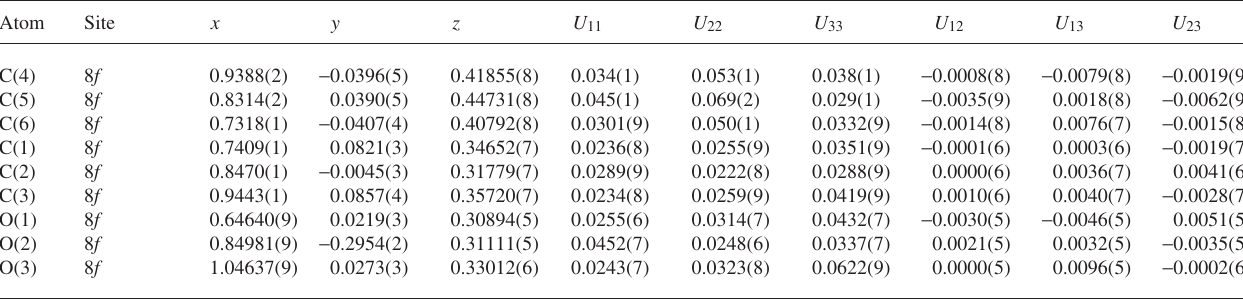
Table 3. Atomic coordinates and displacement parameters (in Å 2 )